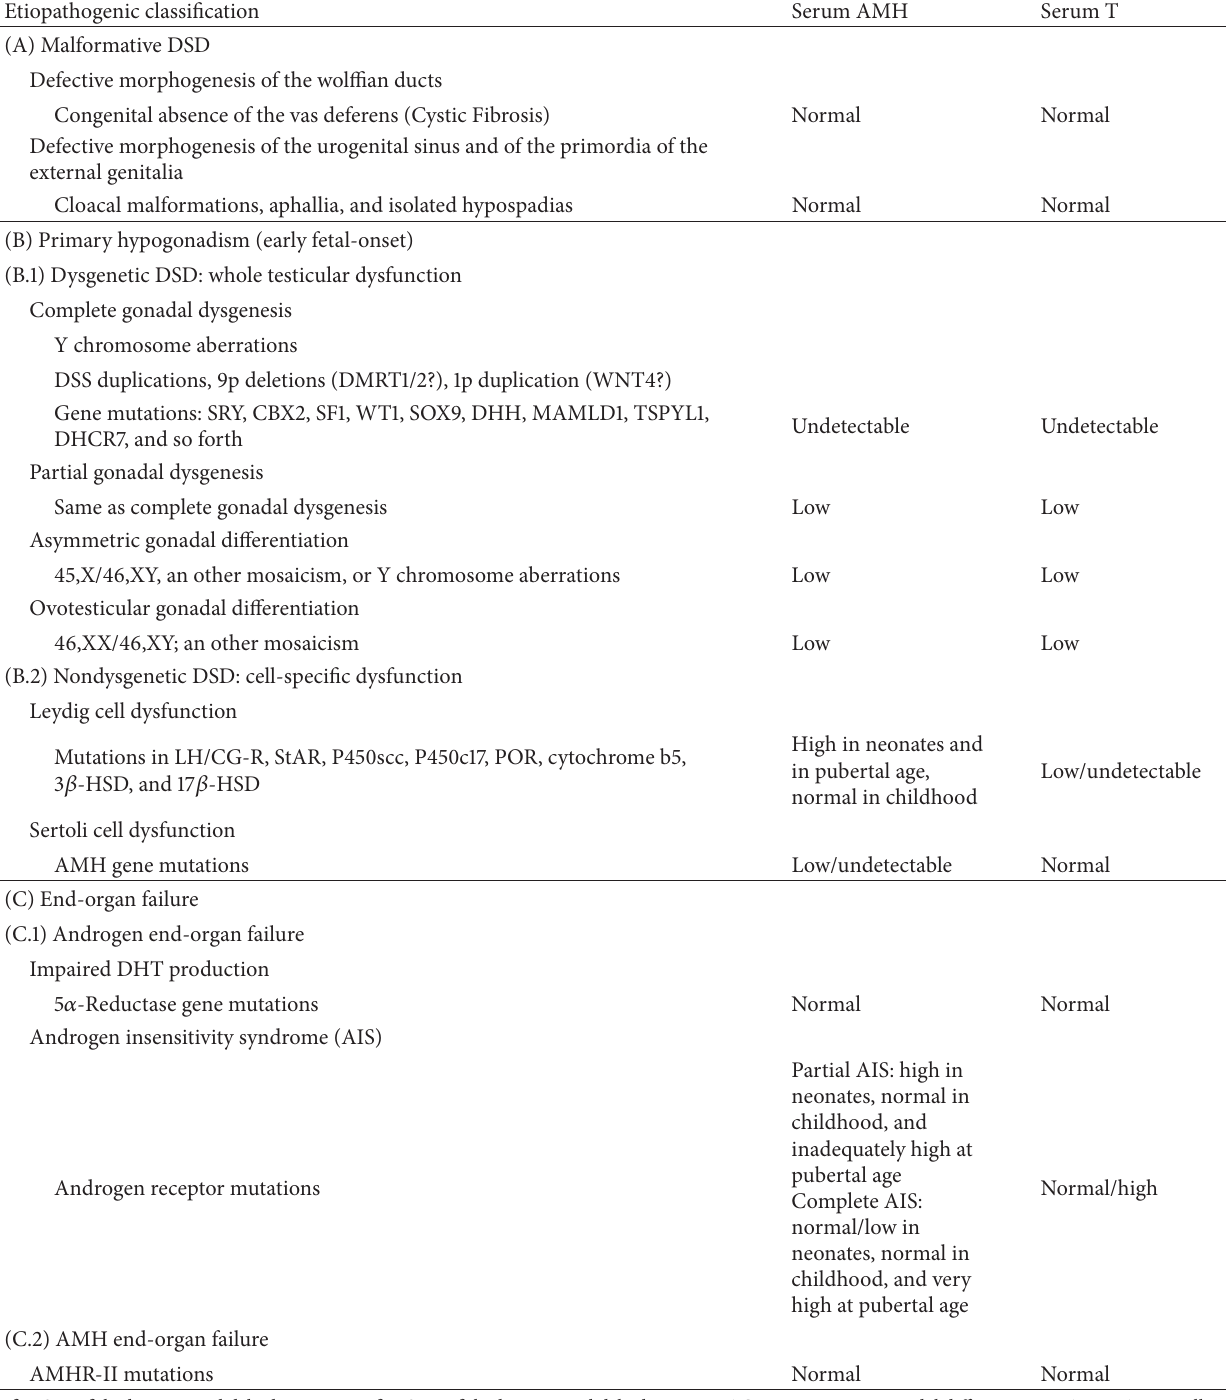
Table 1: Etiopathogenic classification of disorders of sex development (DSD) in patients with a Y chromosome. Etiopathogenic classification Serum AMH Serum T